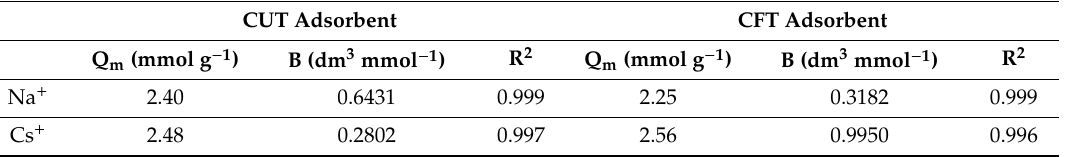
Table 2. Langmuir isotherm constants for the adsorption of Na + and Cs + on adsorbents. CUT Adsorbent